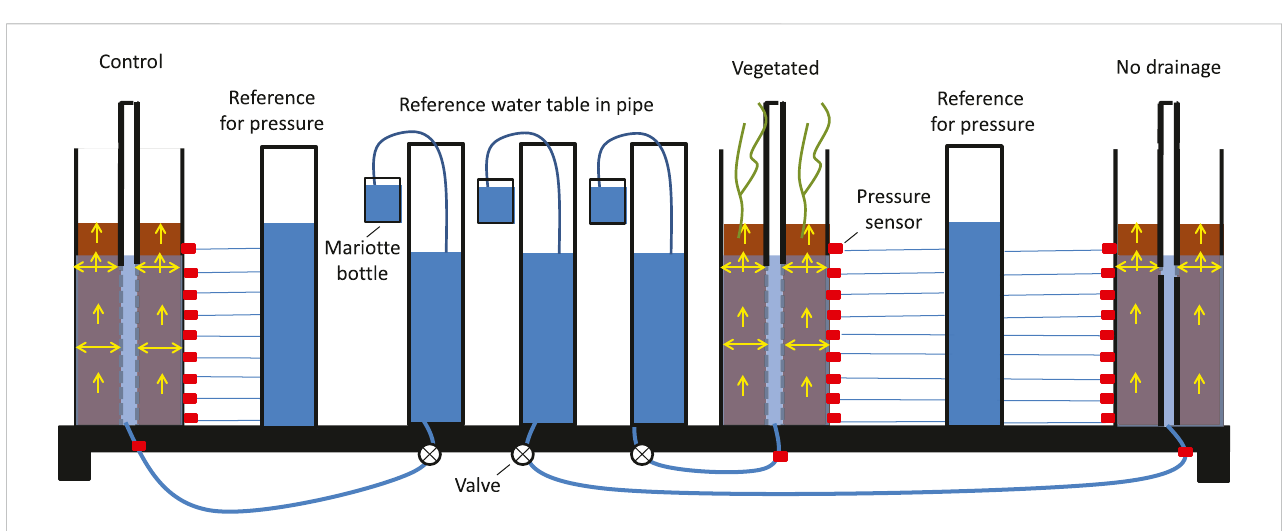
FIGURE 1 Sketch of the setup, including three columns fi lled with dredged sediment: a control column (only sediment, no vegetation), a vegetated column, and a controlcolumnwithnodrainage.Thecolumnsareequippedwithpressuresensors(redsquares)andadrainagepipetoinduceaconstantwatertableinallthe columns. The water table in all the drainage pipes is induced at 77 cm by connecting them to a column with a reference and constant water table. Each column is connected to its own reference water table to measure the water fl ows. These water fl ows are measured with Mariotte bottles that keep the referencewatertableconstantandallowquantifyingwatertransport.Forthecontrolandthevegetatedcolumns,thedrainagepipeispermeableoveralength of 72 cm. For the column without drainage, horizontal fl ow is only allowed between 70 and 72 cm to prescribe the same reference water table of 77 cm. All pressure measurements are taken relative to a column with constant water height and pressure to increase accuracy.